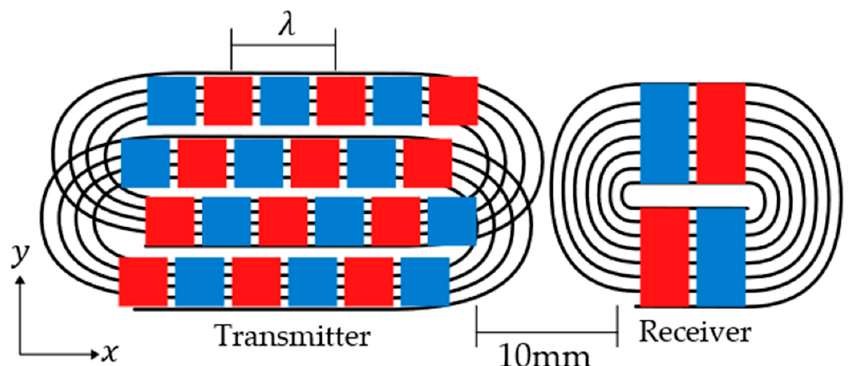
Figure 7. Diagram showing the magnet and coil arrangement of the unidirectional reduced receiver setup. 10 × 10 mm magnets were used for the transmitter and 20 × 10 mm magnets were used for the receiver.